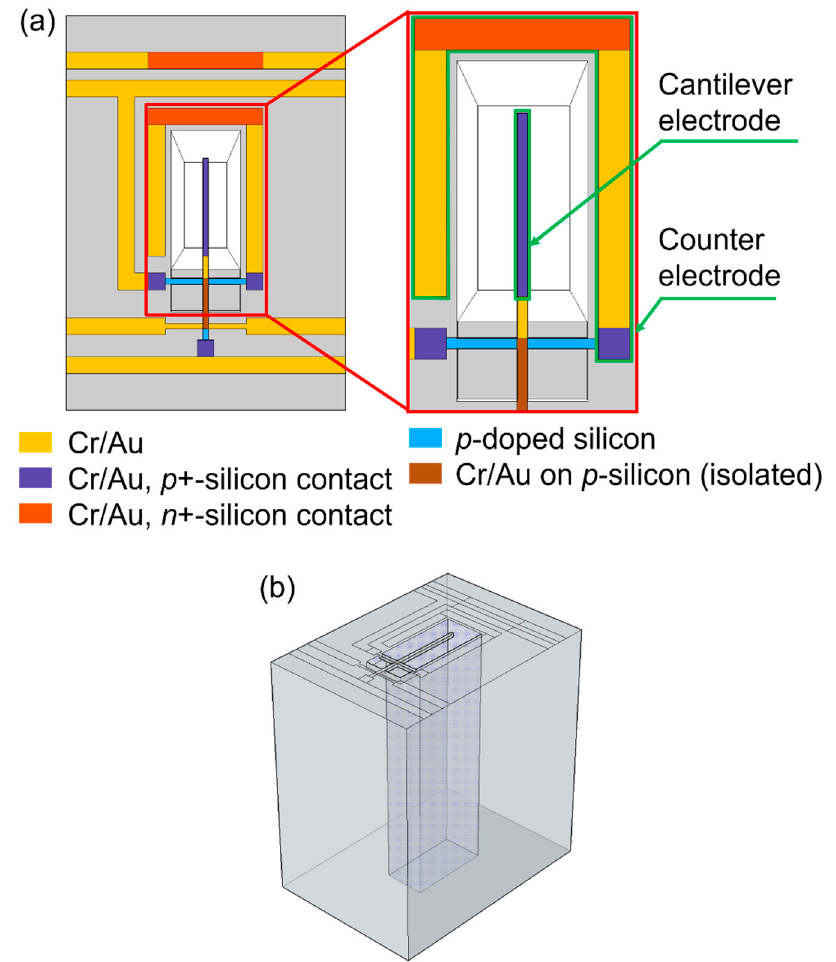
Figure 3. ( a ) Top and ( b ) axonometric schematics of the sensor design.